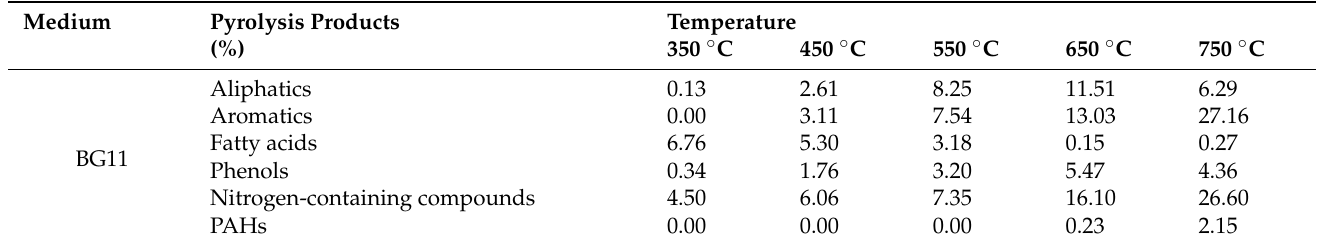
Table A4. The product contents of microalgae residues obtained from three kinds of medium (BG11, AW and MAW) at different pyrolysis